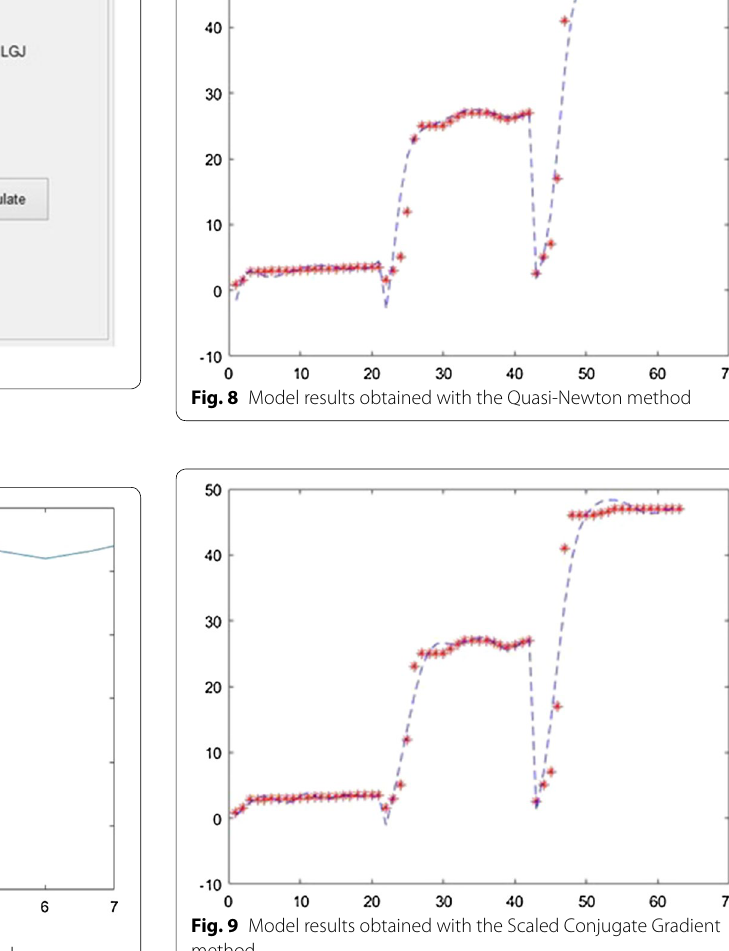
Fig. 6 Predicted values based on the developed model